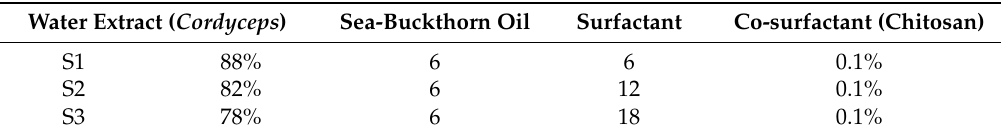
Table 1. Optimization of the Cordyceps nanoemulsion preparation